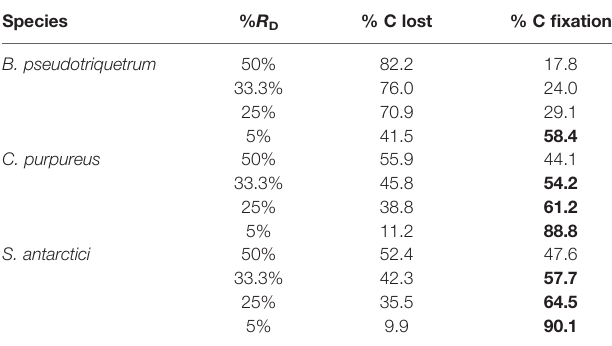
TABLE 3 | Estimated carbon balance for three East Antarctic species calculated from surface temperature data (see Daily Moss Surface Temperature Near Casey Station, East Antarctica ) and temperature response of A sat (see Mesophyll Conductance and NPQ Measurement ). Species